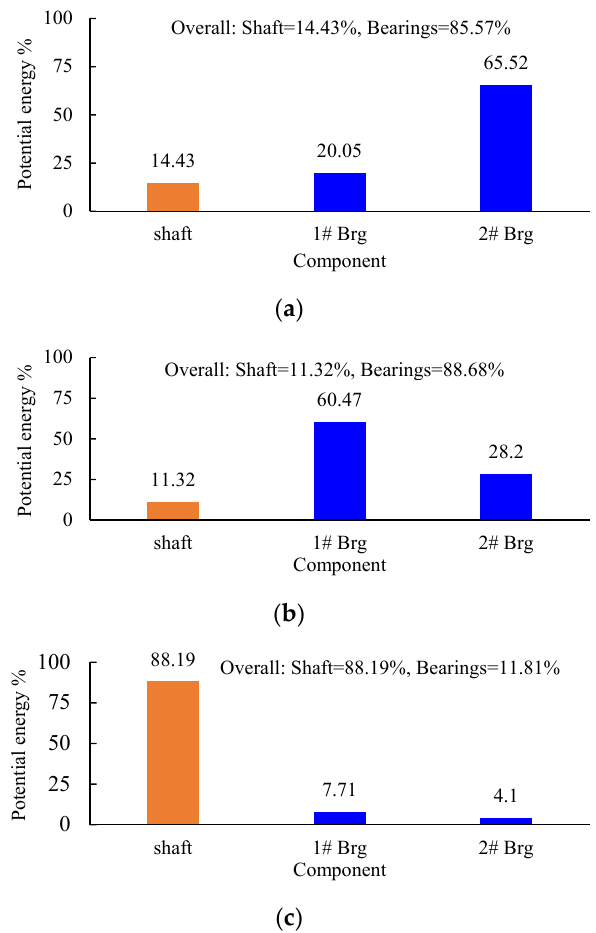
Figure 9. Energy distribution corresponding to the first three modes. ( a ) First order. ( b ) Second order. ( c ) Third